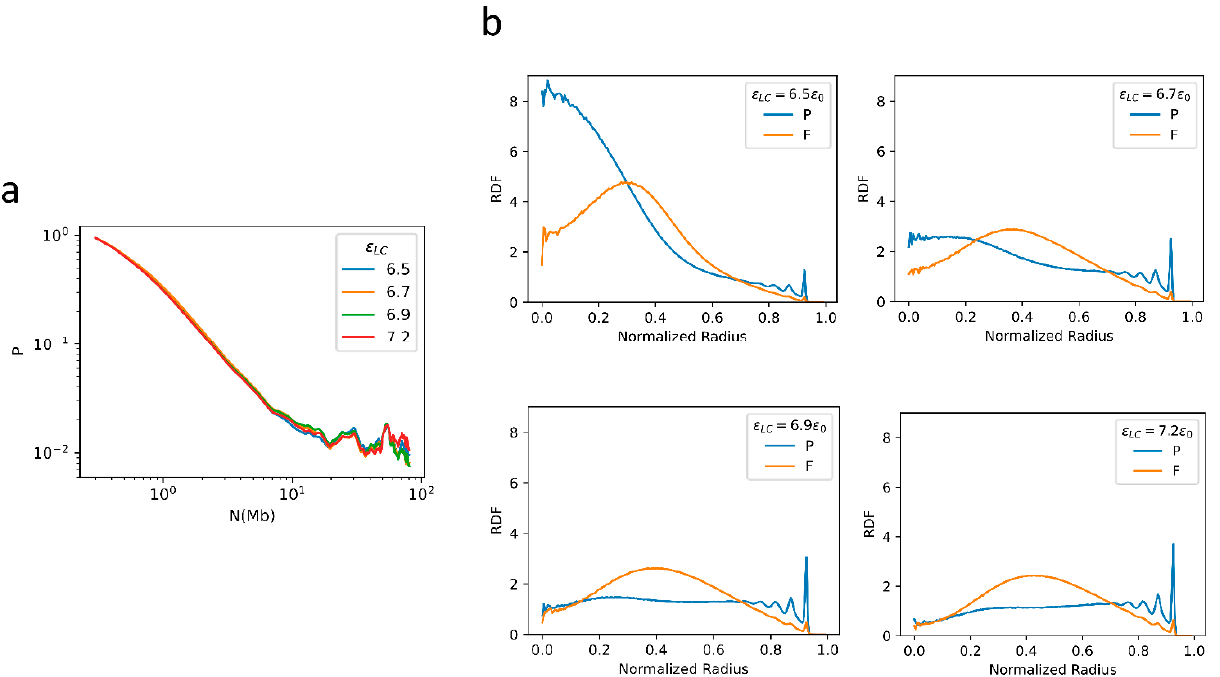
Figure 5. ( a ) The contact probability as a function of sequential distance generated from the 1-Chr system with different ε LC values; ( b ) the RDFs obtained from the chr10 simulation with different ε LC values.